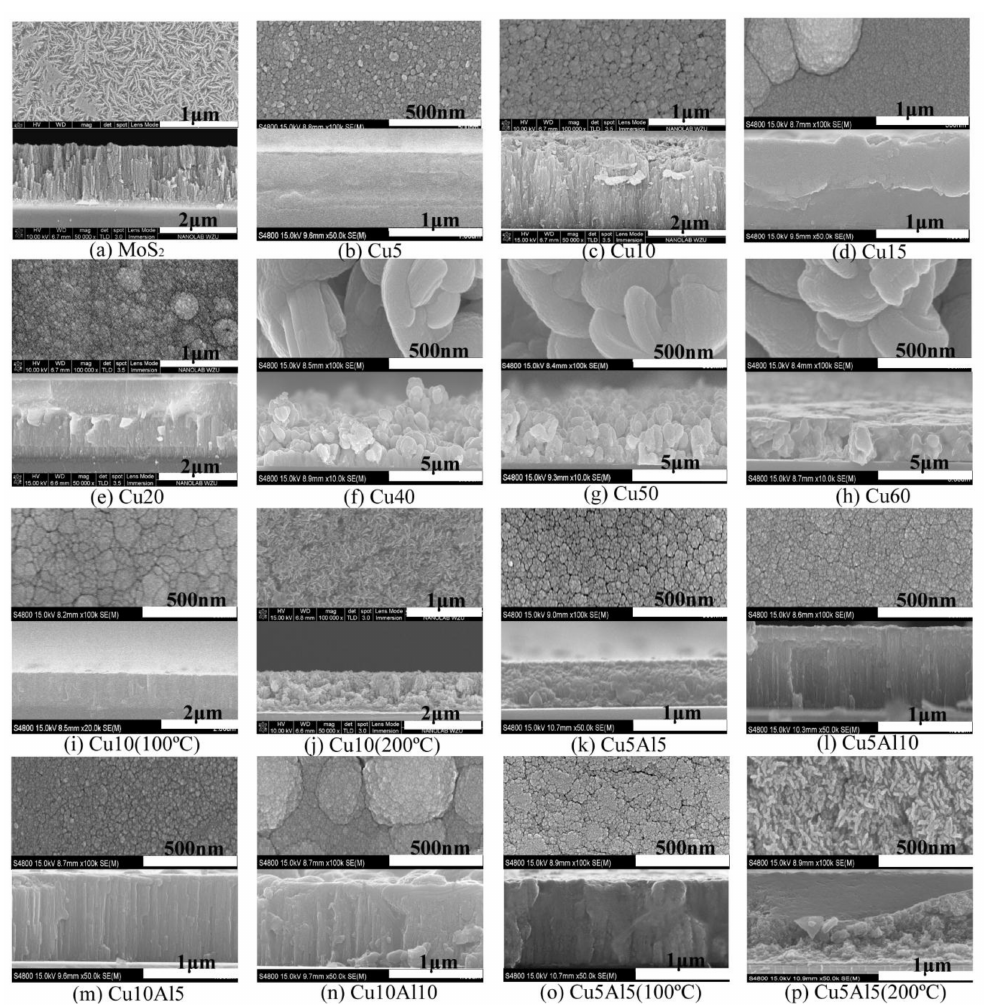
Figure 1. SEM surfaces and cross-sectional morphologies of composite coatings on silicon